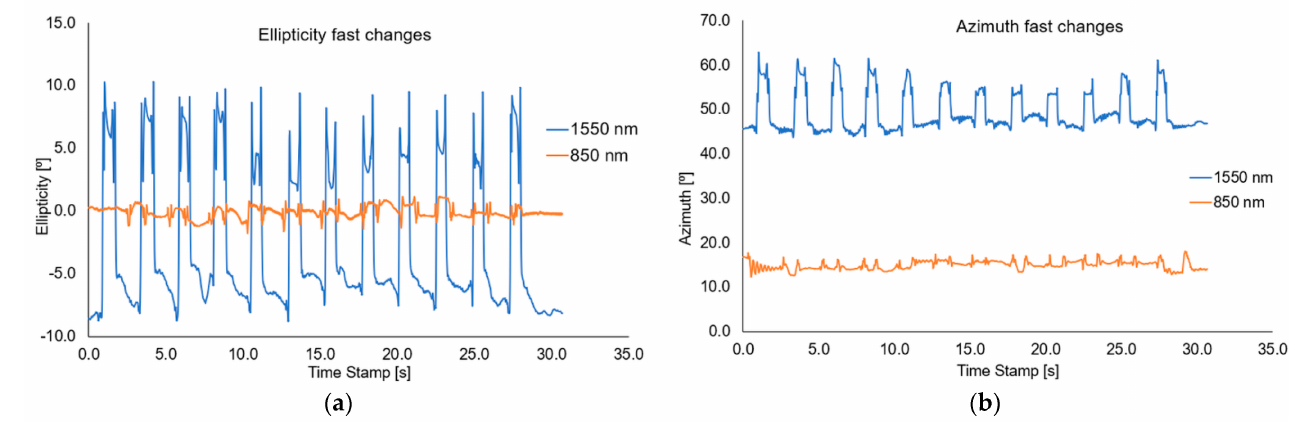
Figure 16. Graphs of influence of sliding the magnetic mixture on change the ellipticity ( a ) and azimuth ( b ) for a rapid sweep of magnetic field for wavelengths of 850 nm and 1550